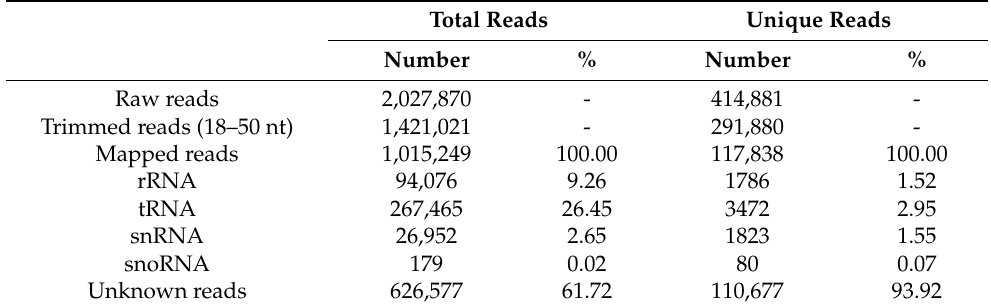
Table 1. Composition of RNA library. Screening performed against an Ensembl Fungi file containing specific A. bisporus